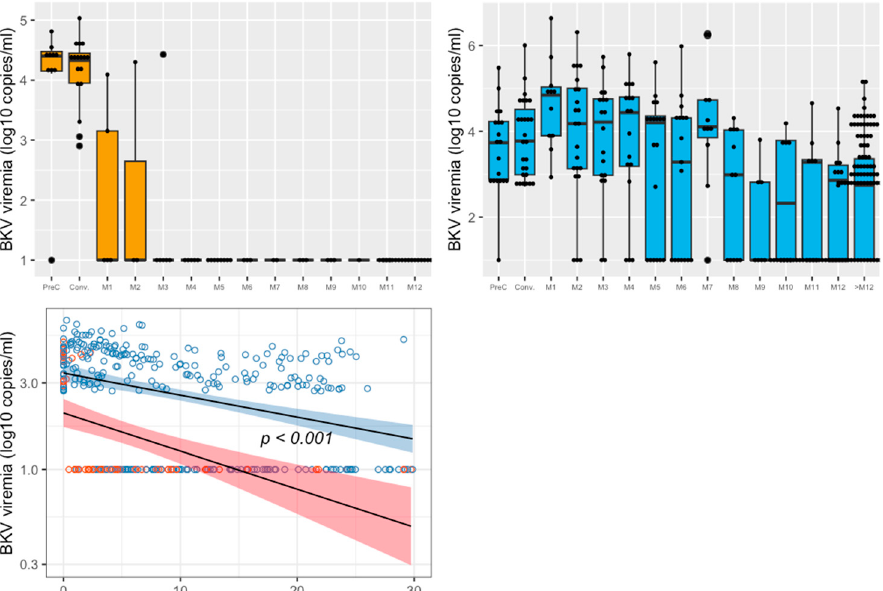
Figure 2. Upper figures: BKV DNAemia (log10 copies/mL) at the time of medical intervention, each month from M1 to M12 and after 1 year post-treatment in both groups. The control group (immunosuppression reduction) is represented in the upper-left panel and the mTORi ± IVIg group in the upper-right panel. BKV: BK virus; mTORi: mammalian target of rapamycin inhibitor, PreC: pre-conversion, i.e., before medical intervention. Conv: conversion, i.e., medical intervention. Bottom figure: BKV DNAemia kinetics (log10 copies/mL) over time between medical intervention and M12 in both groups. The mTORi ± IVIg group is represented in blue, the control group is represented in red. Undetectable BKV DNAemia was considered as 1 log10/mL to allow graphical representation.